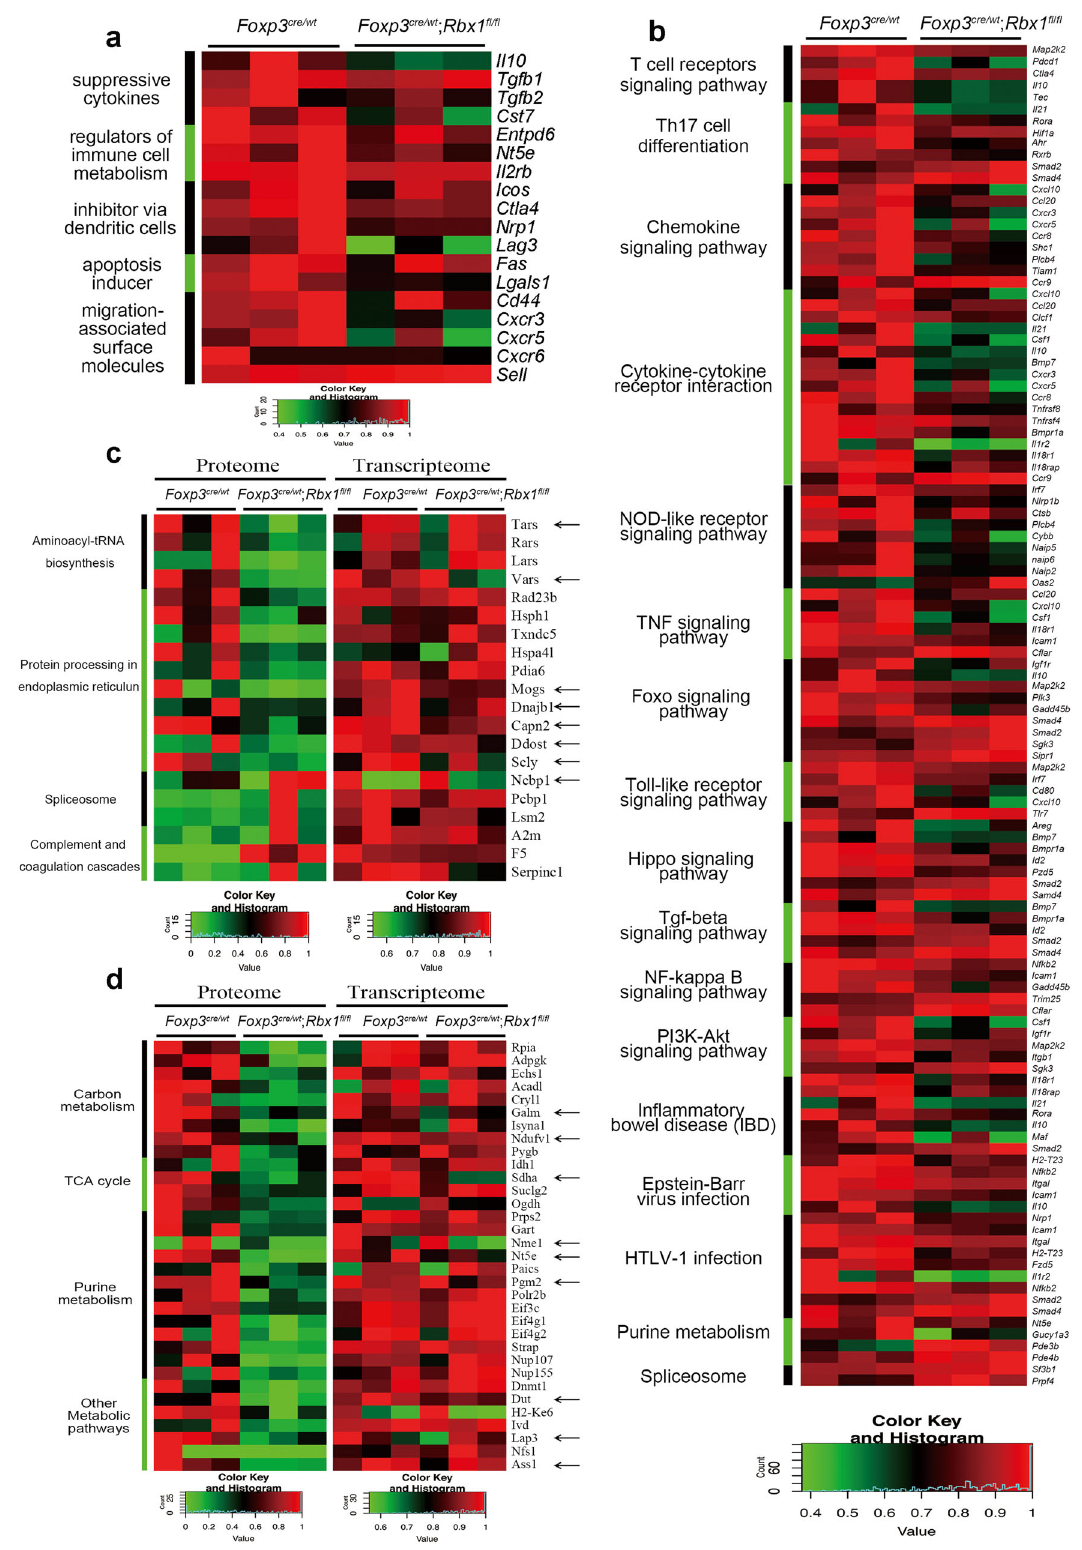
Foxp3 cre ; Ube2m fl / fl mice can be largely rescued by intraperitoneal injection of wt Treg cells, as evidenced by a largely normal proportion of both effector/memory T cells (CD44 hi CD62L lo ) among populations of Tcon cells (Fig. 8e) and proliferation rate of Tcon cells (Fig. 8f), suggesting that impaired immune suppressive function in Foxp3 cre ; Ube2m fl / fl mice are